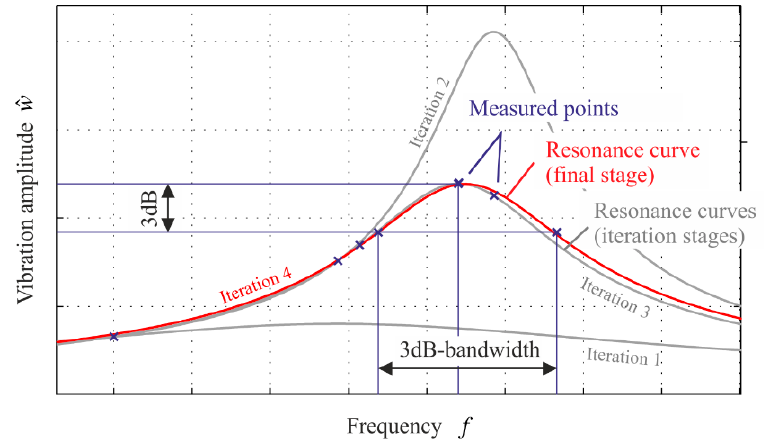
Figure 2. Illustration of the iterative process of fitting a resonance curve to the measured data(based on [23].